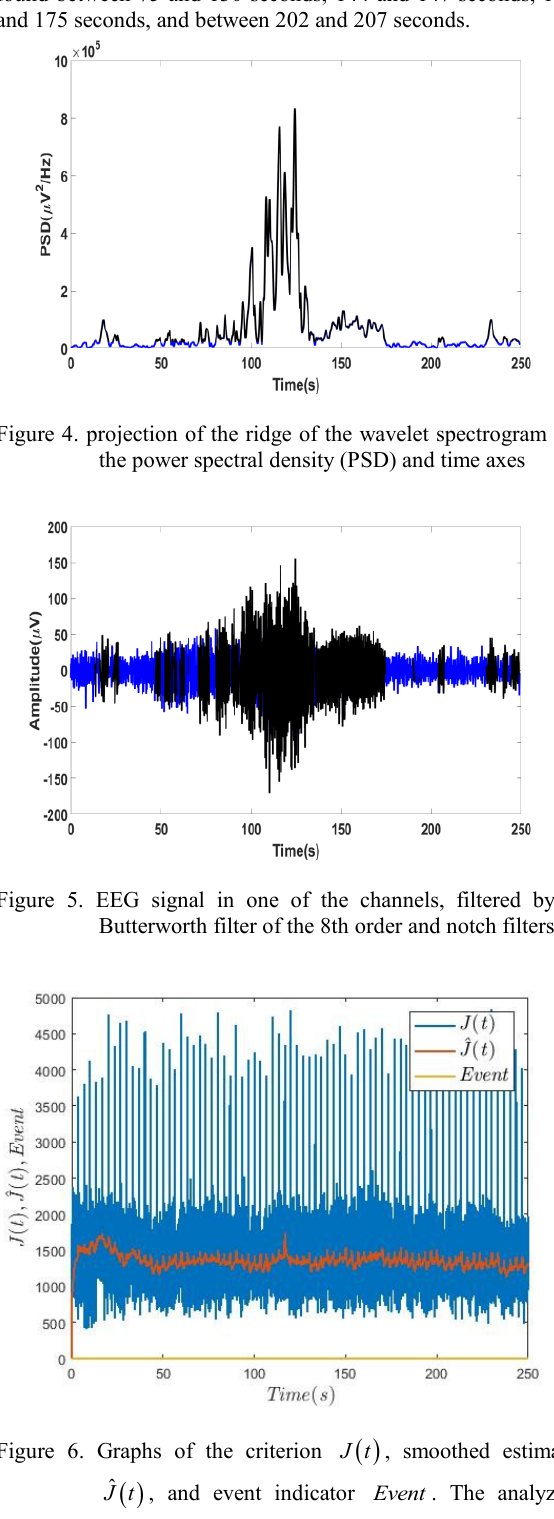
Figure 8. Projection of the ridge of the wavelet spectrogram on the power spectral density (PSD) and time axes Figure 9 shows the filtered EEG signal in one of the